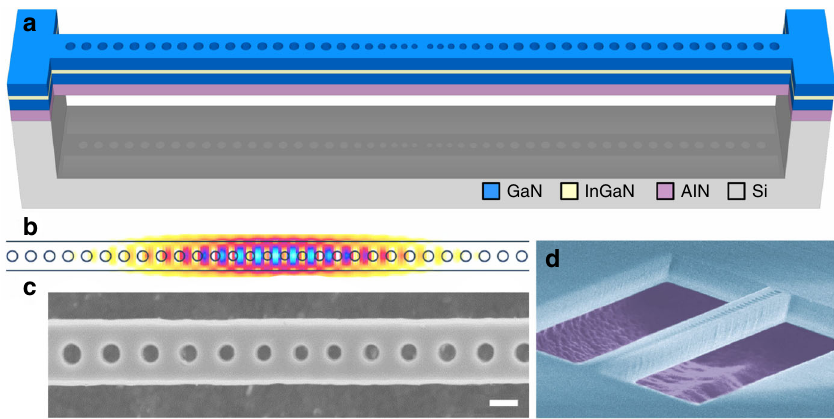
Fig. 1 III-nitride nanobeam cavity membrane. a Schematic drawing of a freestanding nanobeam structure featuring a single InGaN/GaN QW. It consists of two photonic crystal mirrors tapered down to the cavity (not drawn to scale for clarity). b Field intensity pro fi le | E y | 2 of the fundamental cavity mode as obtained via 3D-FDTD simulations. c , d Top and side-view scanning electron microscope images of typical nanobeam structures, where the III-nitride layer, the airgap, and the silicon underneath (false-color in d ) are noticeable. The scale bar in c is equal to 100 nm